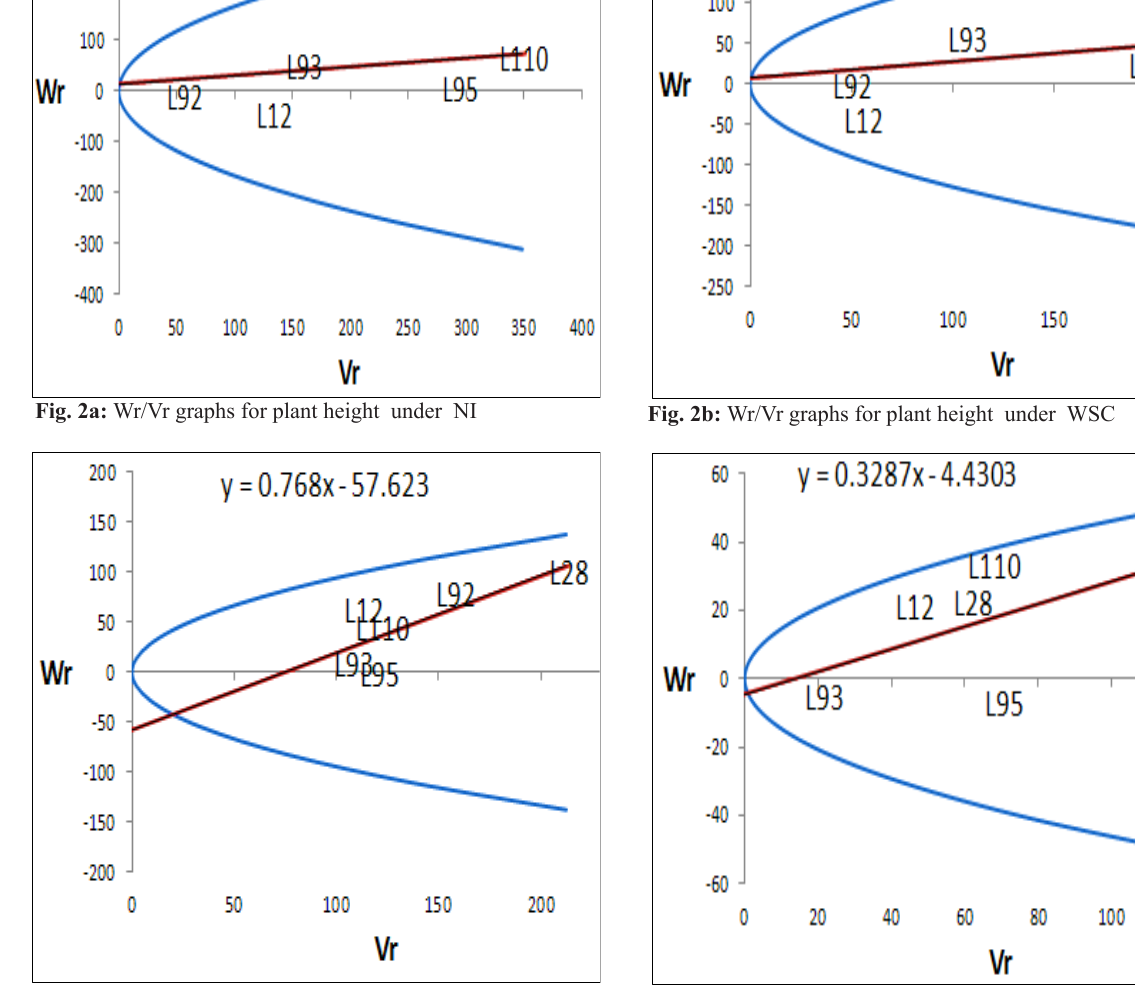
Fig. 3a: Wr/Vr graphs for fruiting zone length under NI Fig. 3b: Wr/Vr graphs for fruiting zone length under WSC